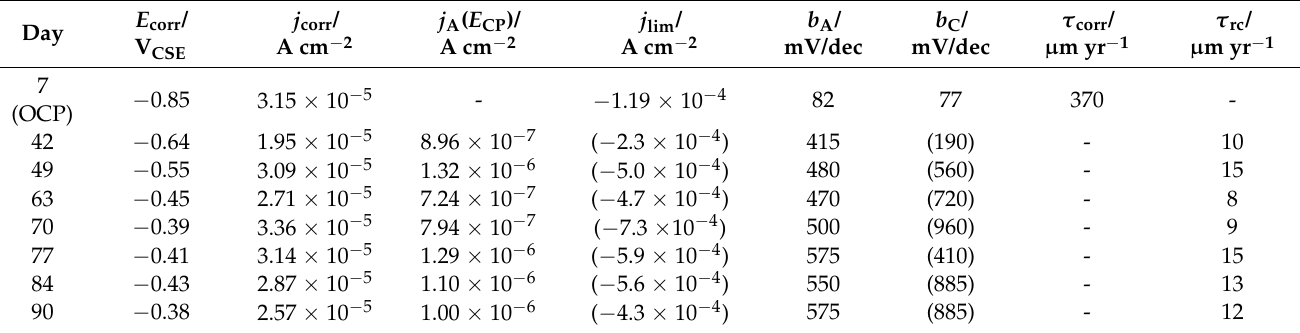
Figure 10. Polarization curves for coupons WE CP2 ( a ) and WE CP1 ( b ) at day 49: detailed view. Experimental-curve (back dots), fitted-curve (grey full line), anodic (blue line) and cathodic (red line) components drawn using the obtained electrochemical parameters. Table 5. Summary of the fitted parameters computed from mathematical modelling for coupon WE CP2 (CSE = copper/copper sulfate electrode). The values for b C and j lim are in brackets as the error is high (about ±50 %).